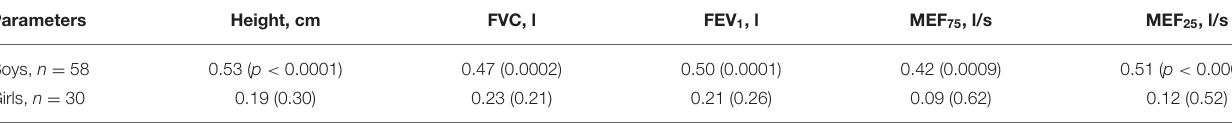
TABLE 4 | Correlation of absolute values of total nasal airflow to height and spirometry parameters in boys and girls with BA. Parameters Height, cm FVC, l FEV 1 , l MEF 75 , l/s MEF 25 , l/s Boys, n = 58 0.53 ( p < 0.0001)